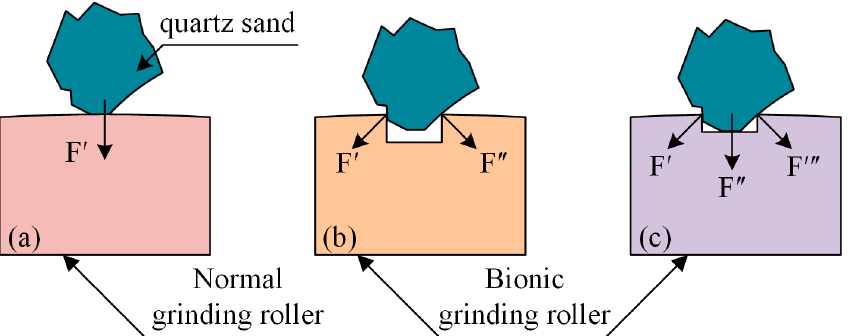
Figure 9. The influence of different contact interfaces on the forces of sand. ( a ) contact between quartz sand and grinding roller; ( b ) contact between quartz sand and the bionic grinding roller with the deeper groove; ( c ) contact between quartz sand and the bionic grinding roller with a smaller depth groove.